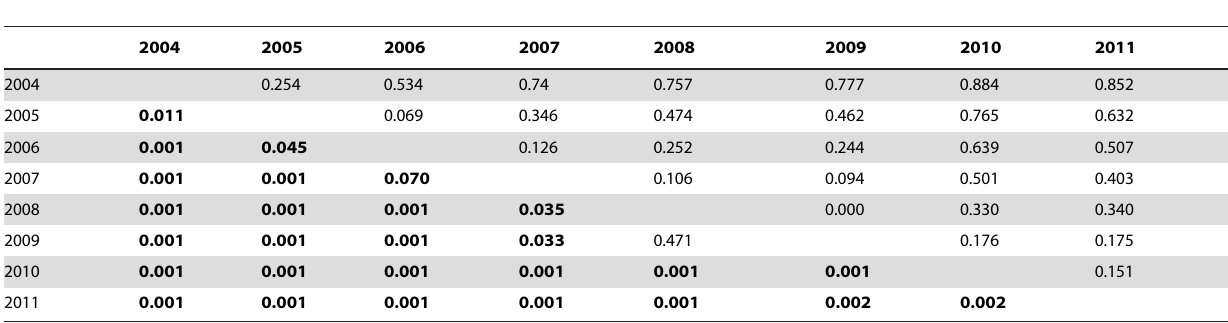
Table 2. ANOSIM results, including R - (top of matrix) and p -values (bottom of matrix) related to the comparisons of community composition between pairs of